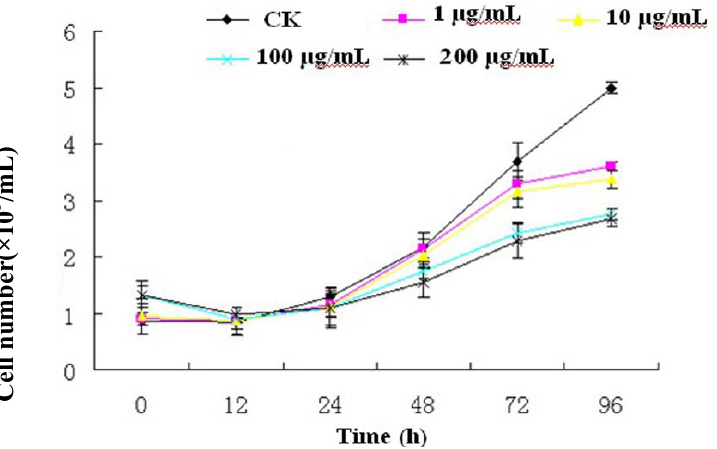
Figure 2. Effects of R-III on the proliferation of Sf9 cells. The cells were grown in presence of 1, 10, 100 and 200 μ g/mL of R-III for the times shown in the figure. Survival cell number was counted by means of Trypan blue exclusion with a standard haemocytometer. Each result derived from the mean of three